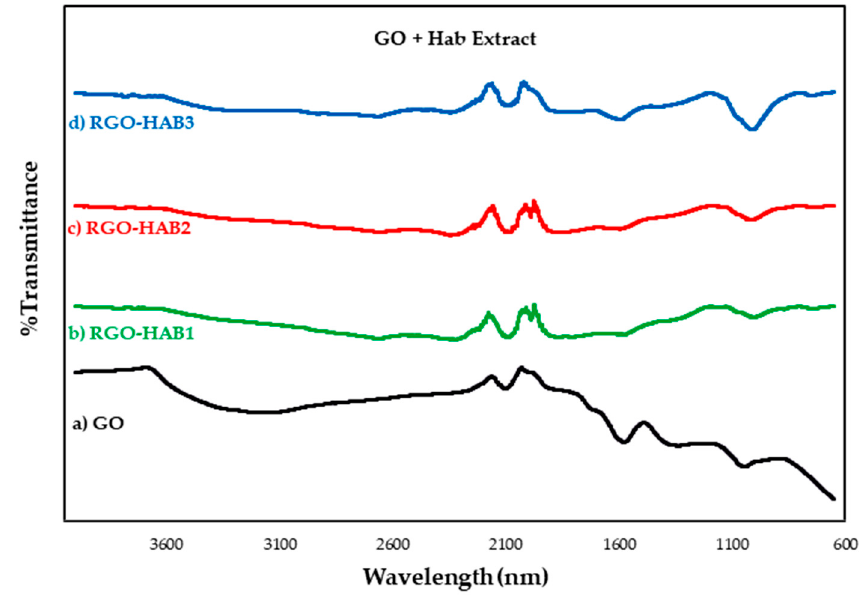
Table 2. Characteristic FTIR absorption bands of oxidized graphite and reduced graphene oxide (RGO). Figure 5. UV–VIS absorption spectrum of graphene oxide (GO) and reduced graphene oxide (RGO) samples with natural extracts: (a) GO (unreduced), (e) RGO-GOB1 5% (f) RGO-GOB2 10% and (g) RGO- GOB3 20%.